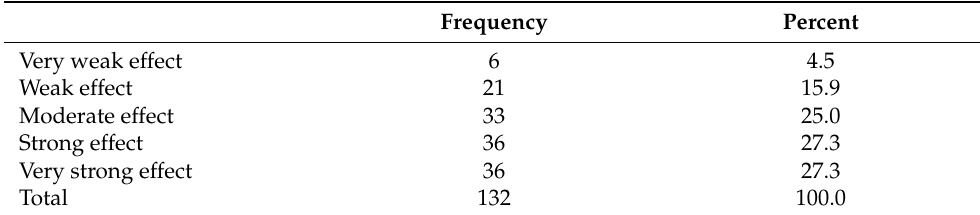
Table 10. Poor land information management